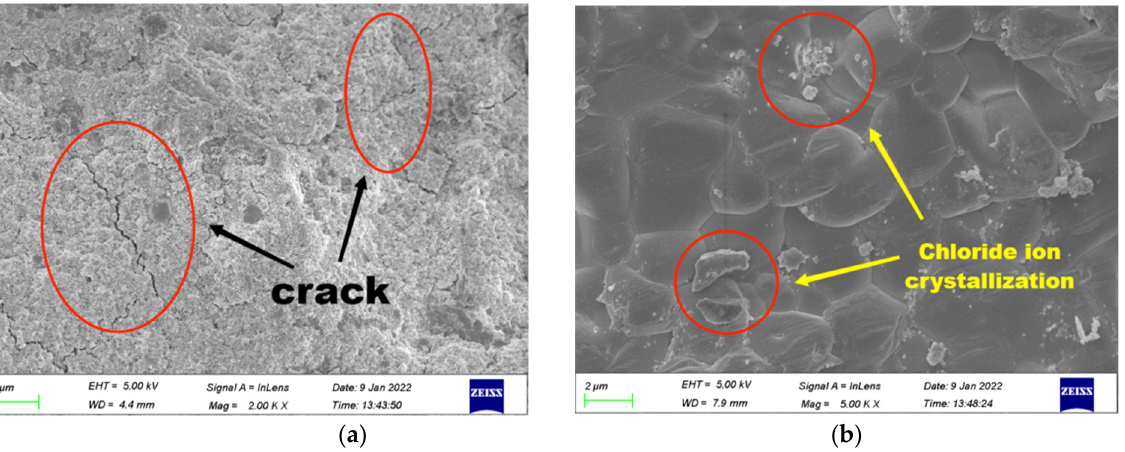
Figure 13. The microstructure of NS–GPC under a coupling environment. ( a ) Microscopic cracks; ( b ) Chloride ion crystallization.